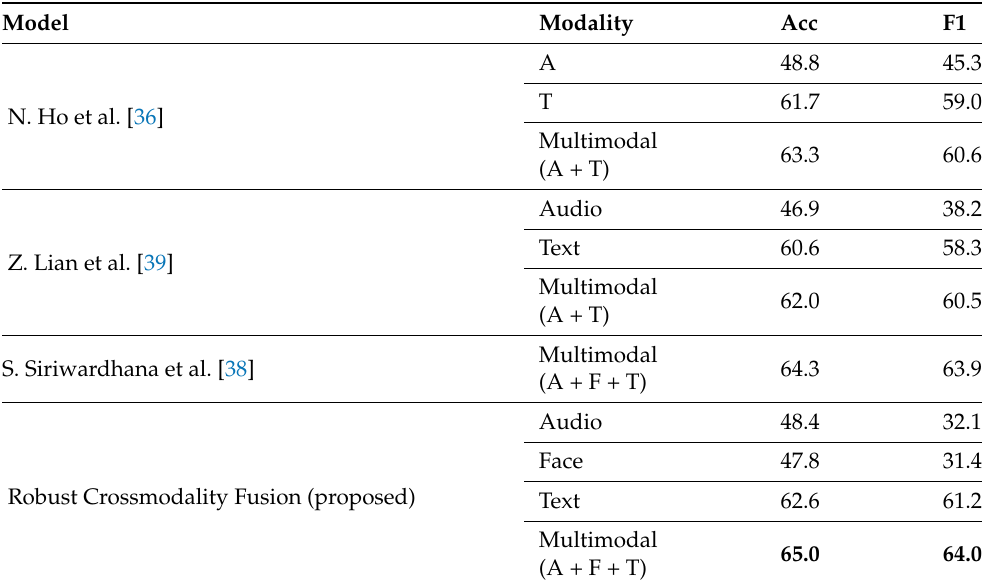
Table 3. The comparison of the proposed model with existing studies (A: Audio, F: Face, T: Text) (Unit =